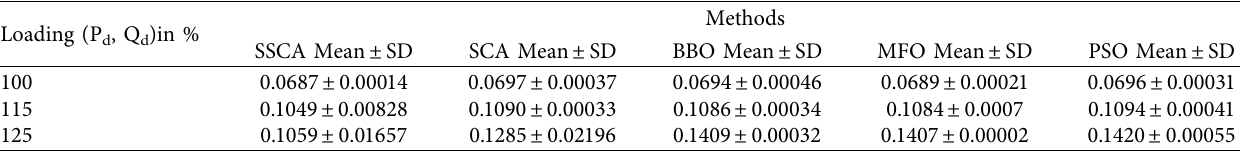
Table 2: Statistical analysis of APL for IEEE 30 bus system.